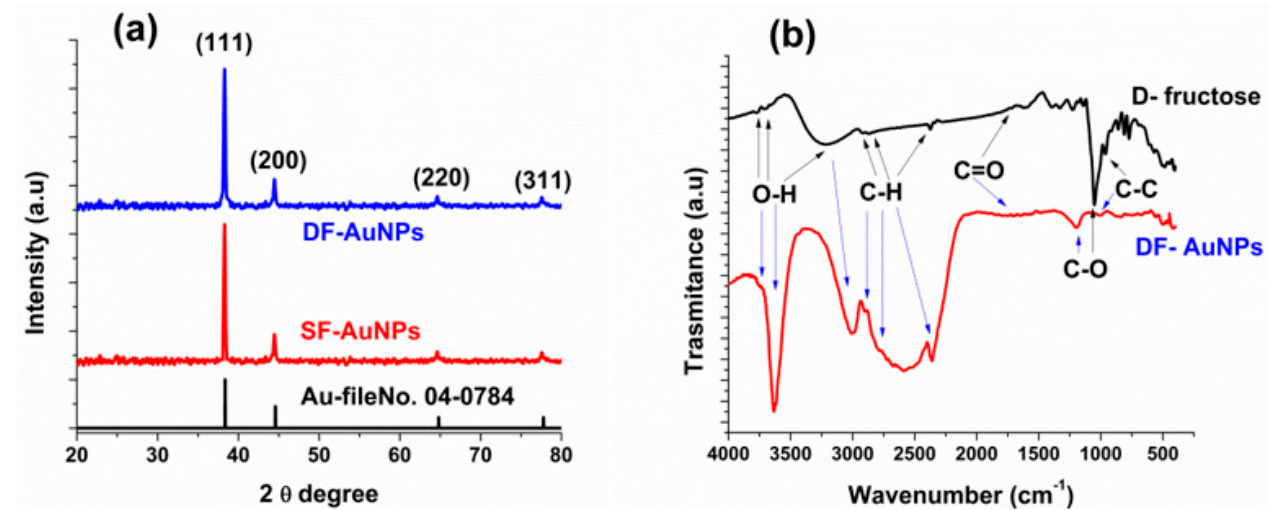
Figure 4. ( a ) XRD spectra of Au-file number 04-0784, SF-AuNPs, DF-AuNPs, ( b ) FTIR absorption spectra of DF and DF-AuNPs.